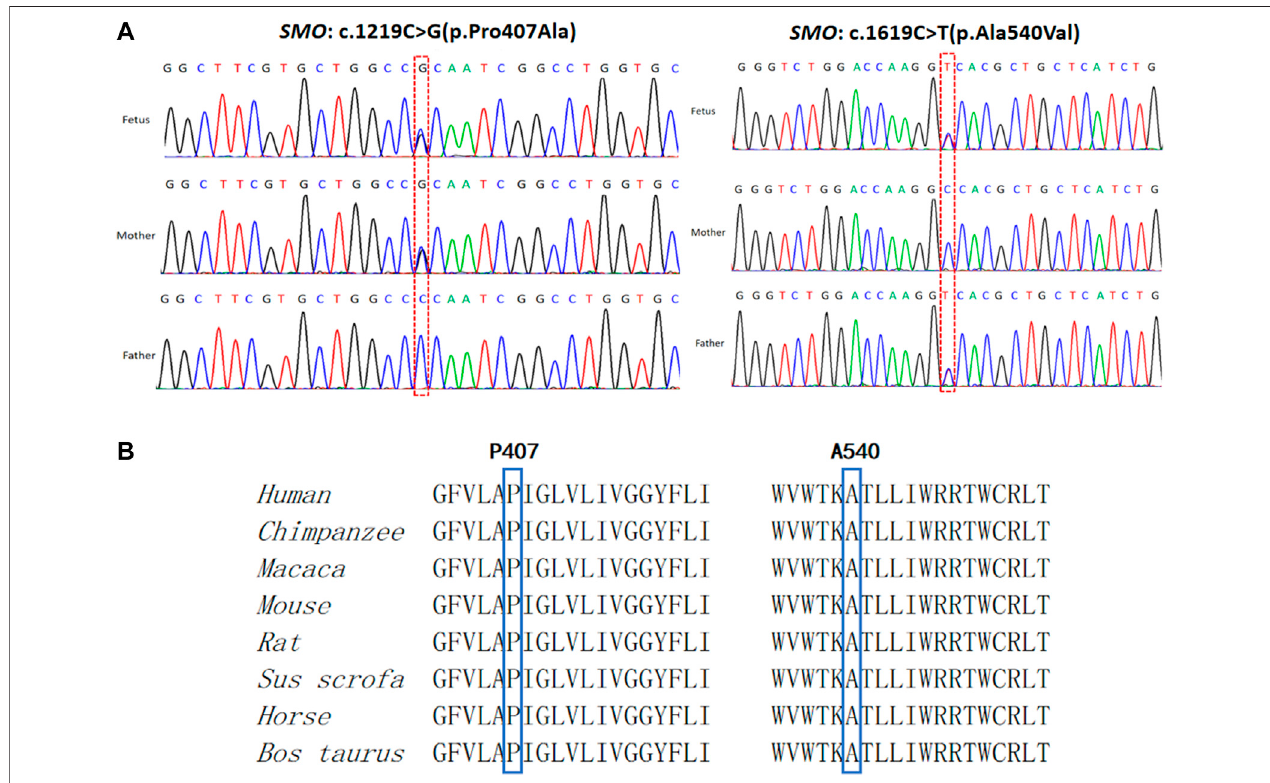
FIGURE 3| Genetic variations identi fi ed inthis case. (A) Two variants detected in the fetus and parents. (B) Conservation of the mutated amino acids(Pro407 and Ala540) across different species.